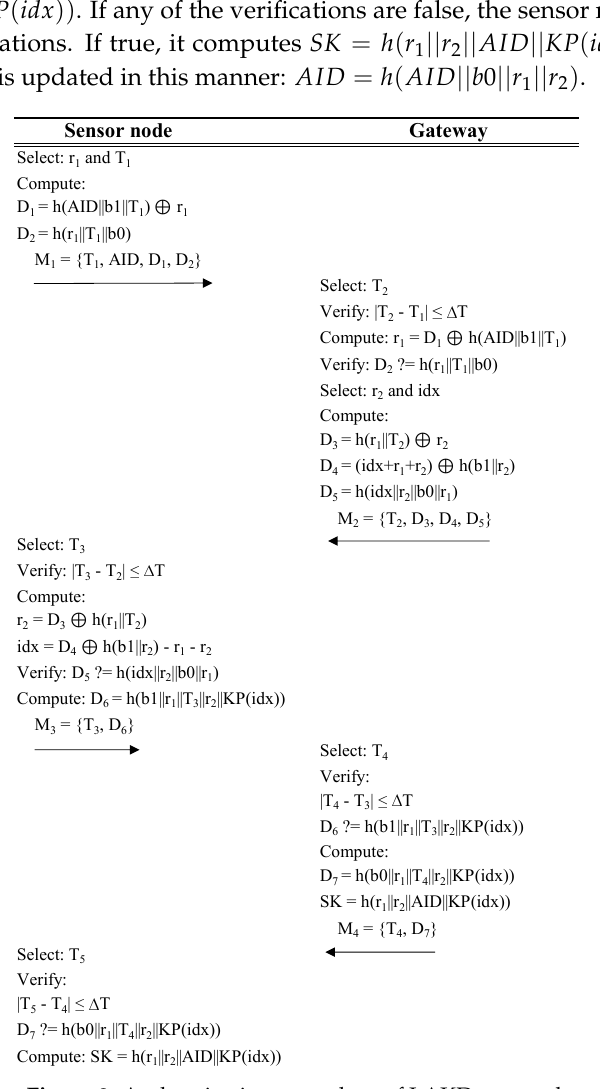
Figure 2. Authentication procedure of LAKD